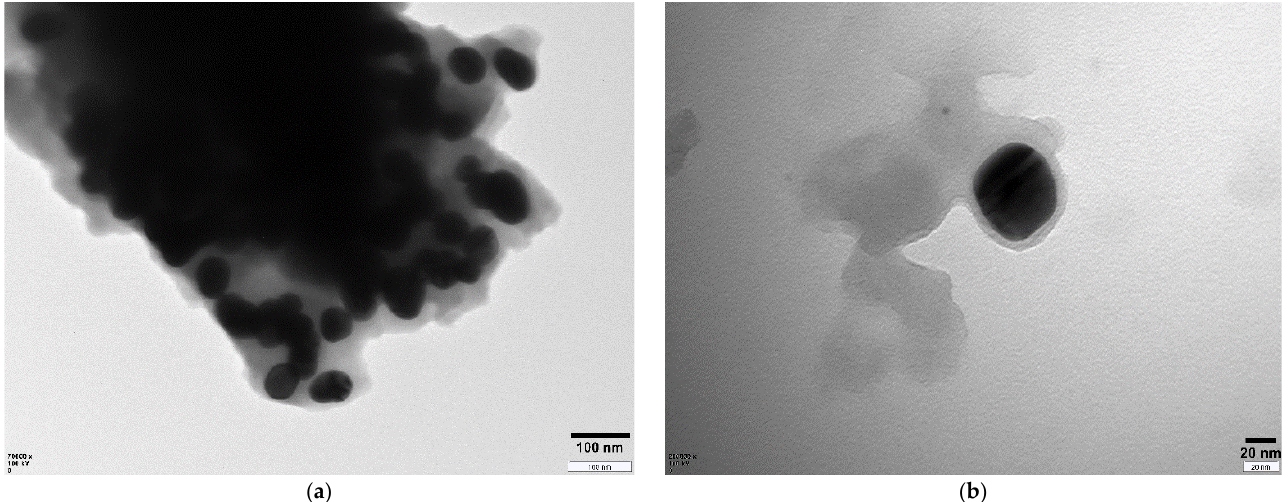
Figure 2. Low ( a ) and high ( b ) magnified TEM micrographs of Ag-CuO NC.